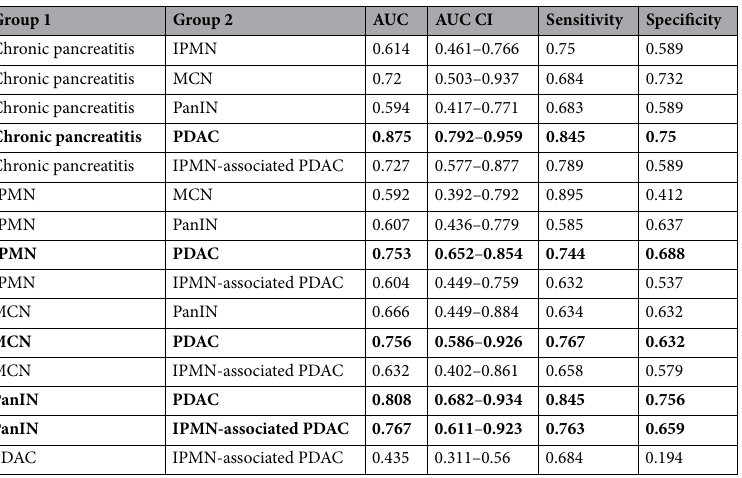
Table 2. Image-wise classification results between the six pancreatic diseases using GaWRDenMap. The rows highlighted in bold indicate classification AUCs that are identified as significant, with 0.75 selected as the threshold value for significance. This value was determined after analysing the results as a whole and on consultation with the physician.